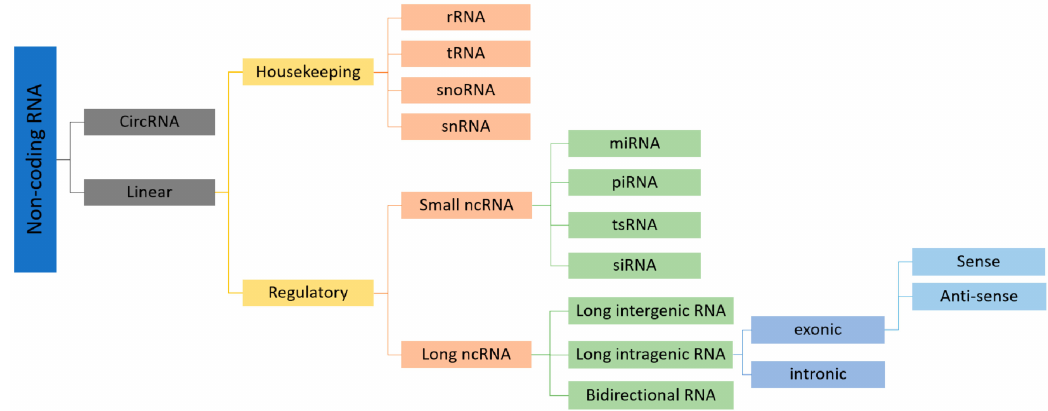
Figure 2. Schematic diagram illustrating the classification of ncRNAs according to their biological role and their